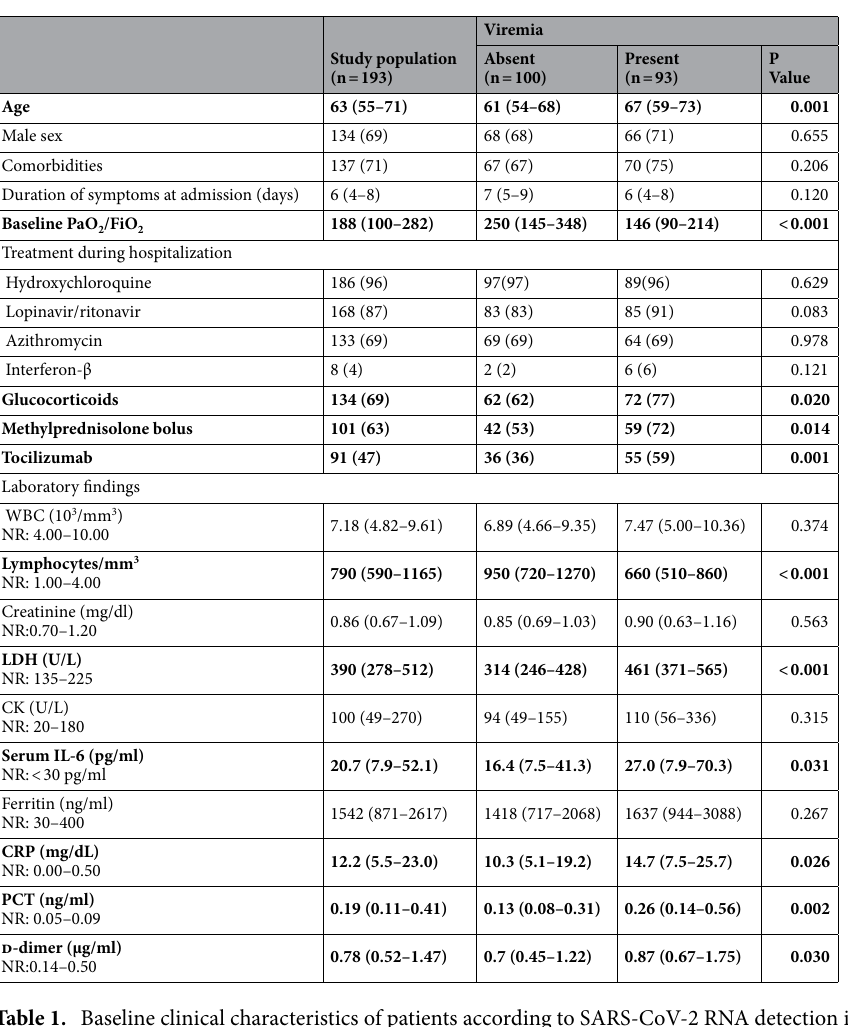
Table 1. Baseline clinical characteristics of patients according to SARS-CoV-2 RNA detection in blood by Roche technique. Bold values express significant differences between groups. All categorical variables are expressed as number (%) and quantitative variables as median (p25-75). PaO 2 /FiO 2 : arterial oxygen tension– fraction of inspired oxygen ratio; WBC: white blood count; NR: normal range; LDH: lactate dehydrogenase; CK: creatin kinase; IL6: interleukin-6; CRP: C-reactive protein; PCT: procalcitonin.